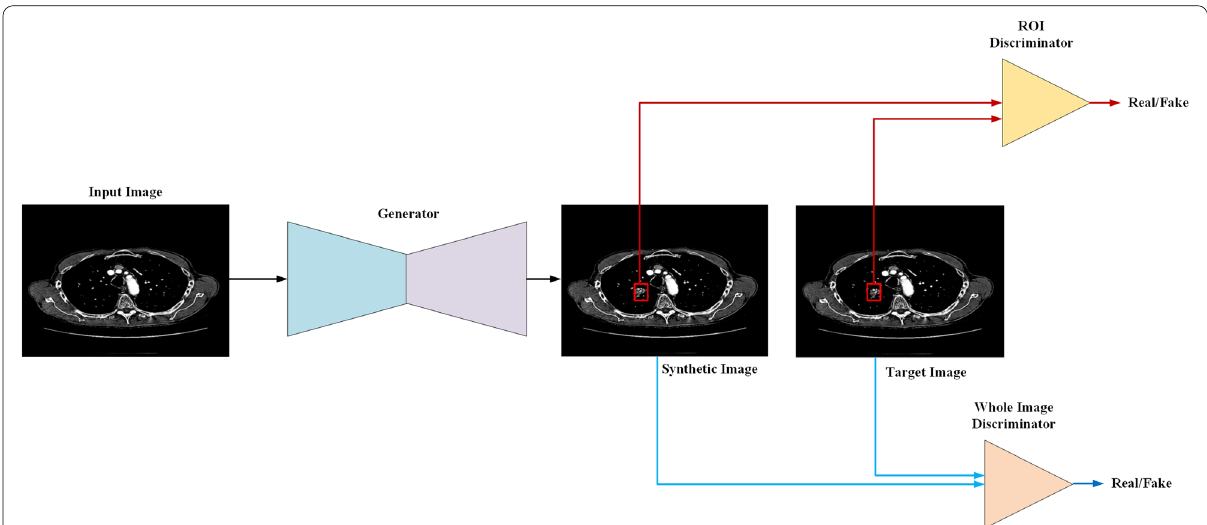
Fig. 1 The pipeline for training the model. First, the generator synthetises ground glass nodules from the background according to the input image. Second, the region of interest (ROI) discriminator (red line) and the whole image discriminator (blue line) extract features from the ROI and whole image to classify the synthetic image and the target whether the synthetic image is